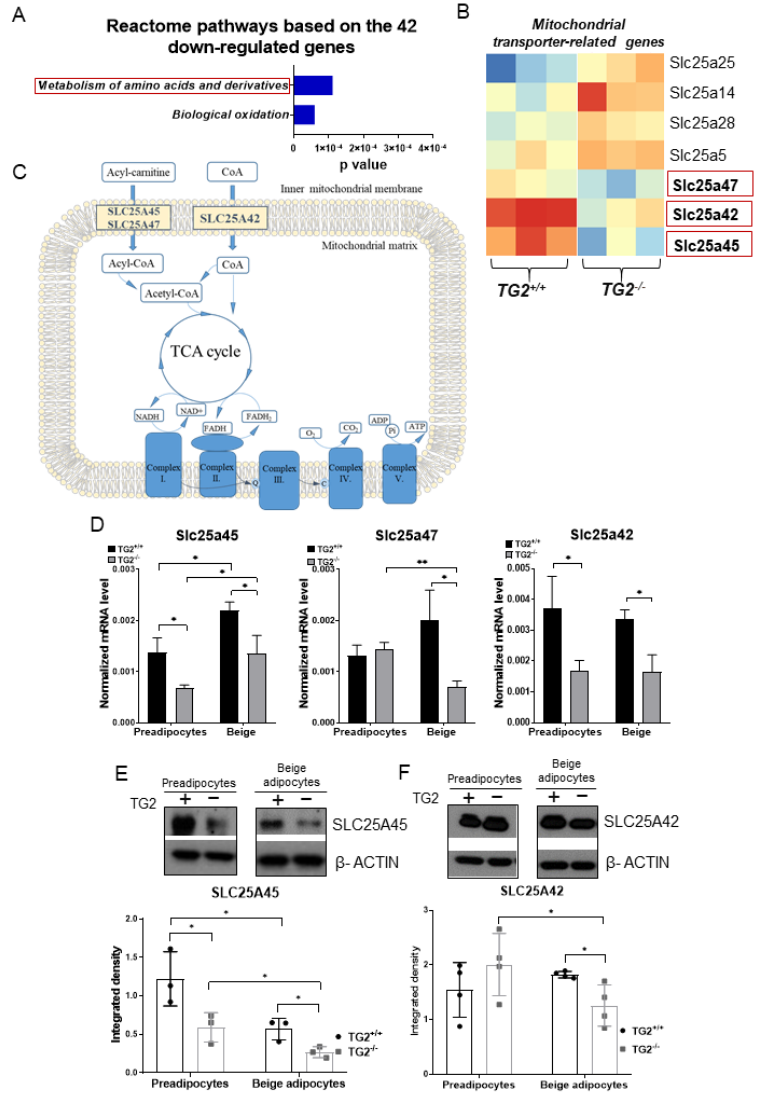
Figure 7. Downregulated mitochondrion-related genes in TG2 −/− beige cells as compared with TG2 +/+ : ( A ) Downregulated Reactome pathways in the TG2 −/− beige samples based on the gene ontology (GO, Reactome pathway) analysis; ( B ) heatmap of differentially expressed mitochondrial transporter genes in beige adipocytes, the framed genes were selected for validation; ( C ) schematic illustration of the roles of selected SLC transporters, the panel is a modification of a figure from [47]; ( D ) validation of the selected mitochondrial transporter genes using RT-qPCR analyses; ( E ) repre- sentative Western blot of SLC25A45 and quantitative analysis in preadipocytes and differentiated beige cells; ( F ) representative Western blot of SLC25A42 and quantitative analysis in preadipocytes and differentiated beige cells. Columns represent the mean values ± SD. Statistical analyses were performed using Student’s t-test. n = 3. * p < 0.05, ** p < 0.01, *** p < 0.001. of human mitochondria [48] and both SLC25A45 and SLC25A47 may also transport amino acids, we investigated the uptake and release of amino acids by the preadipocytes and